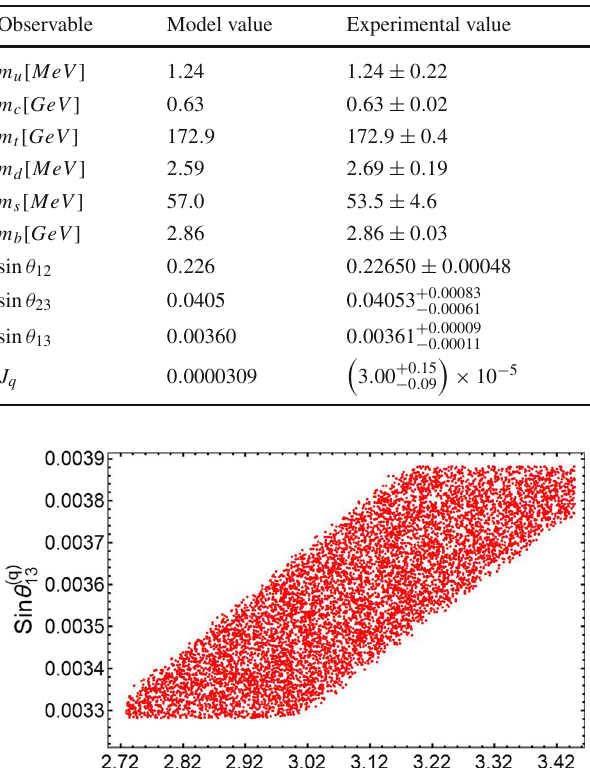
Table 3 Model and experimental values of the quark masses and CKM parameters